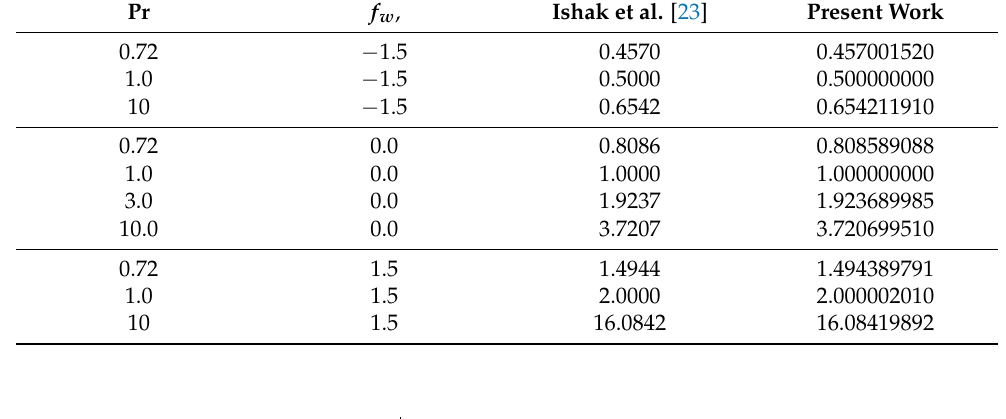
Table 1. Comparison of Nusselt number − θ (cid:48) ( 0 ) for different values of f w and Pr with the results of Ishak et al. [23] when α = β = M = Ec = λ = R = ε = Nt = Nb = 0. Pr